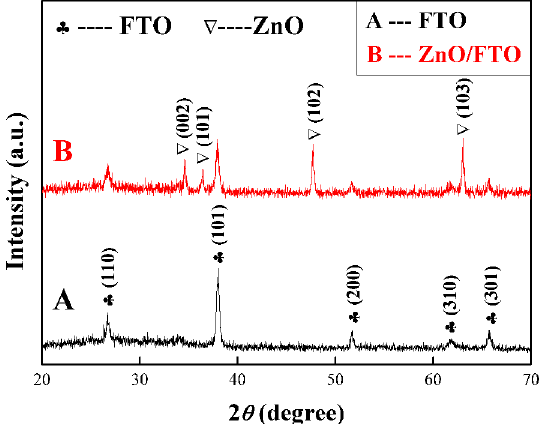
Figure 4. XRD patterns of ( A ) the etched FTO glass and ( B ) ZnO NCs array on the etched FTO glass.